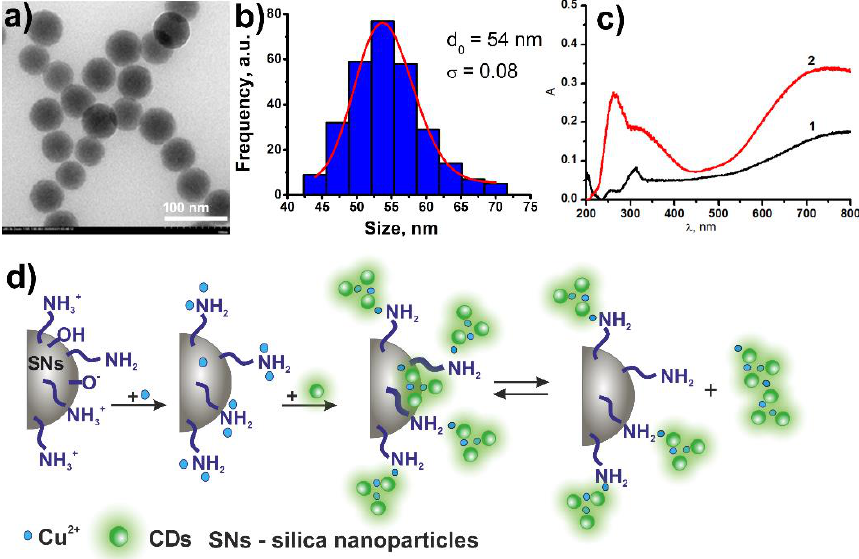
Figure 1. ( a ) TEM image of SNs-NH2; ( b ) the particle size histograms and the corresponding curve fitting of sample SNs-NH 2 (d0—average diameter, σ —log-normal distribution parameter); ( c ) UV- Vis/DR spectra of dried samples of SNs-CuII (1) and SNs-NH 2 -CuII (2); ( d ) schematic representation of the stepwise synthesis of hybrid nanoparticles SNs-NH 2 -CuII-CDs (silanol groups are presented only at the first step not to complicate the figure).